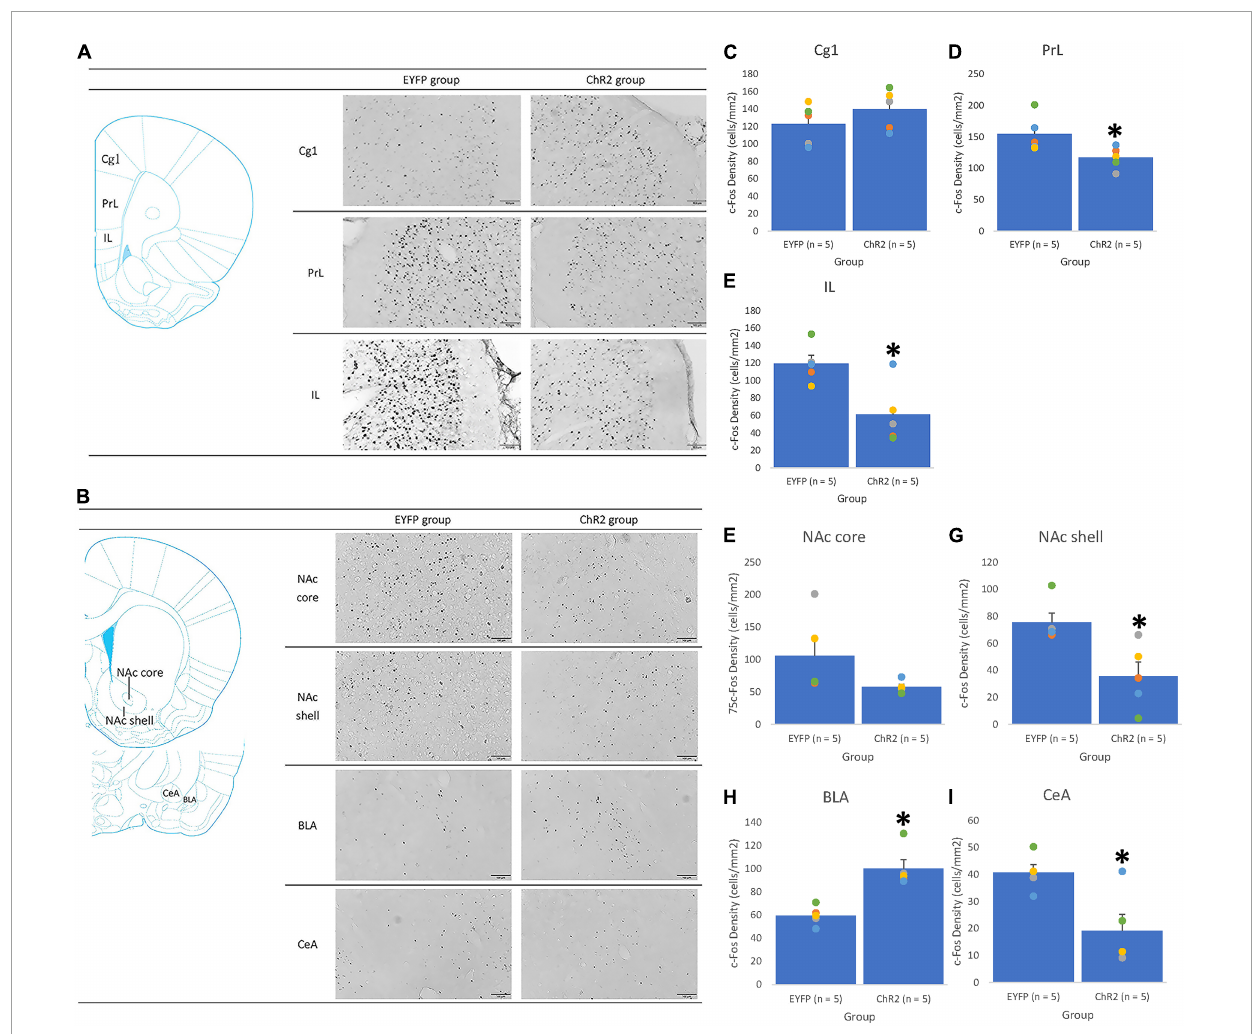
FIGURE6 The Cg1 photostimulation was given in conditioning. An illustrated brain atlas showing (A) the cingulate cortex 1 (Cg1), prelimbic cortex (PrL), and infralimbic cortex (IL); (B) the nucleus accumbens core (NAc core), nucleus accumbens shell (NAc shell), basolateral amygdala (BLA), and central amygdala (CeA). c-Fos density in the (C) Cg1, (D) PrL, (E) IL, (F) NAc core, (G) NAc shell, (H) BLA, and (I) CeA in EYFP ( n = 5) and ChR2 ( n = 5) groups after Cg1 optical stimulation and morphine-induced CTA in conditioning tests. ∗ p < 0.05 compared with the EYFP